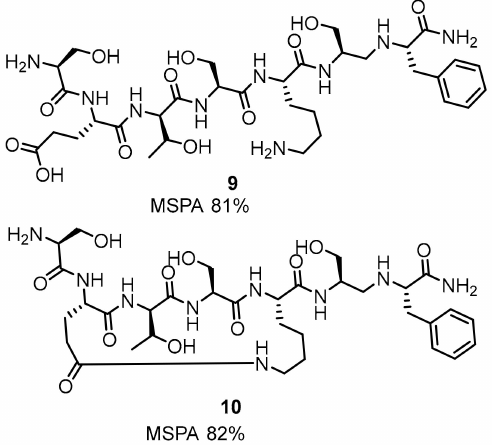
Figure 6. Linear 9 and cyclic peptide 10 showing the highest MSPA